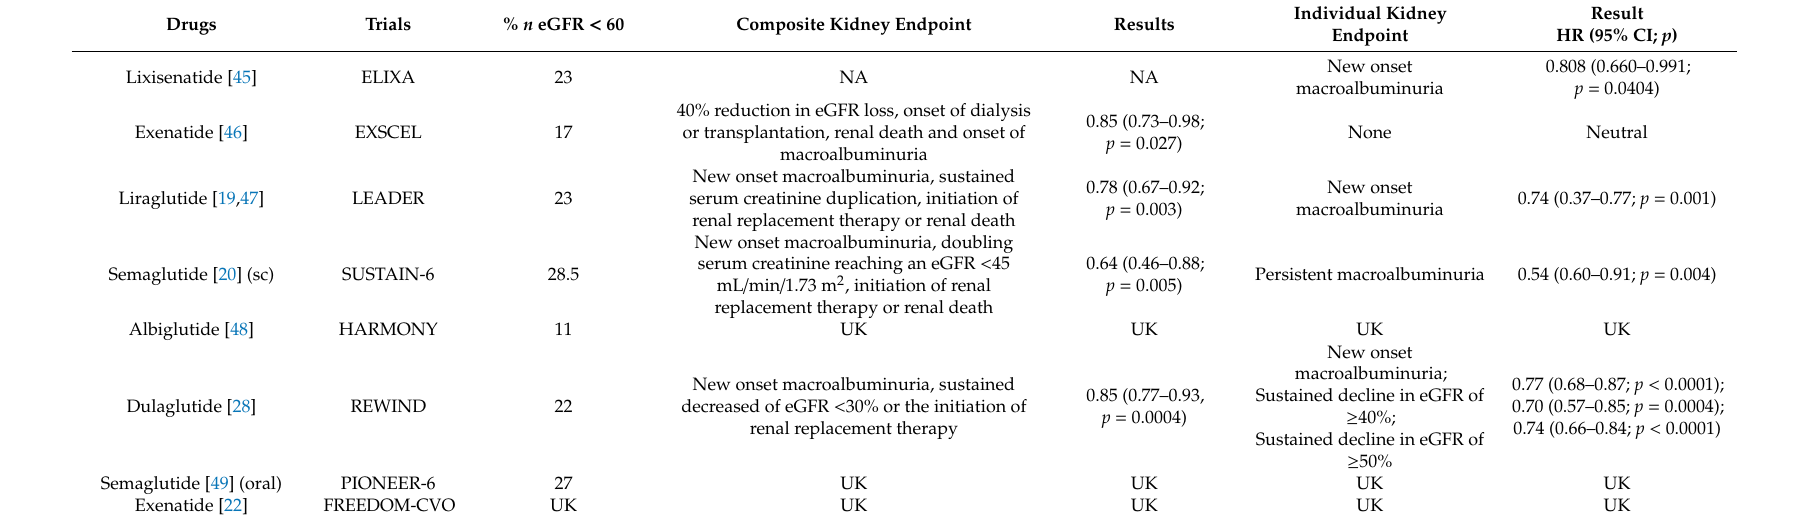
Table 3. Key GLP-1RA RCTs with kidney